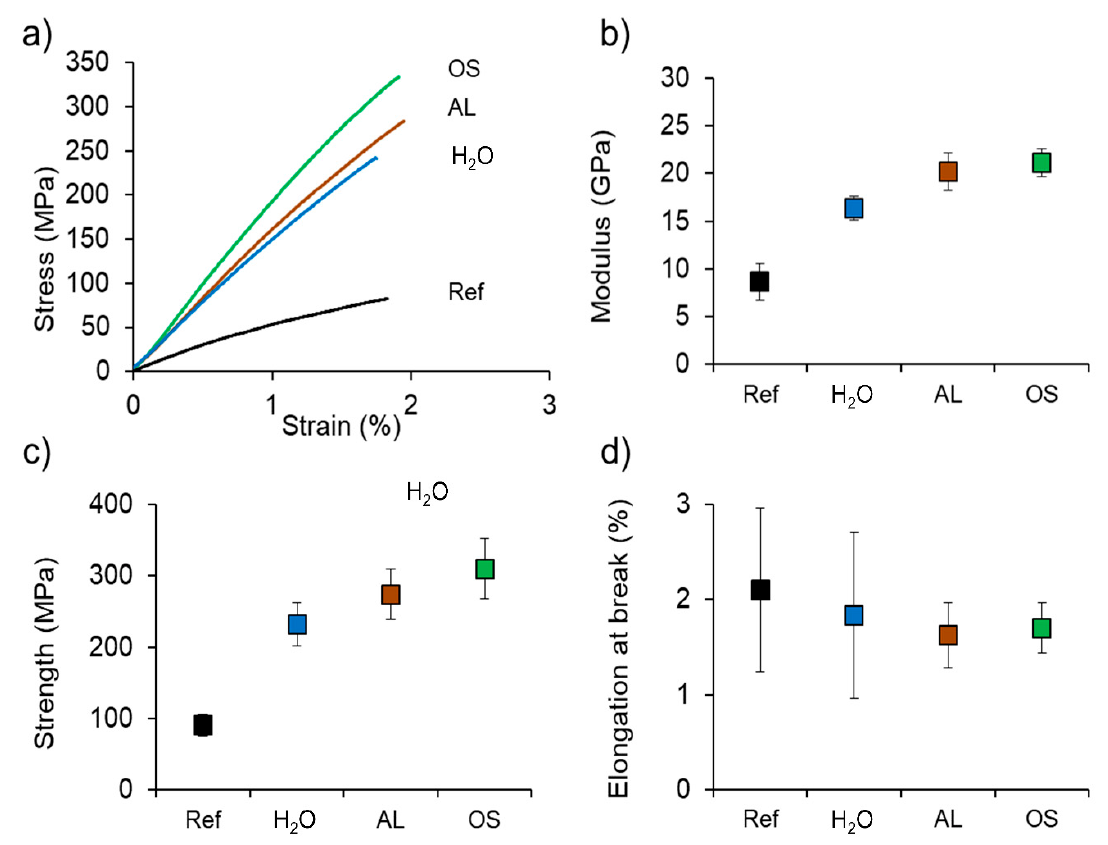
Figure 3. Mechanical characterization of reference (Ref), densified water-soaked (H 2 O), densified alkali-treated (AL) and densified organosolv-treated (OS) spruce veneers conditioned at 20 °C and 65% relative humidity by longitudinal tensile tests: ( a ) Representative stress-strain curves for each treatment; ( b ) Elastic Modulus; ( c ) Strength; ( d ) Elongation at break. ( n = 15 for Ref; n = 10 for H 2 O; n = 10 for AL; n = 10 for OS).